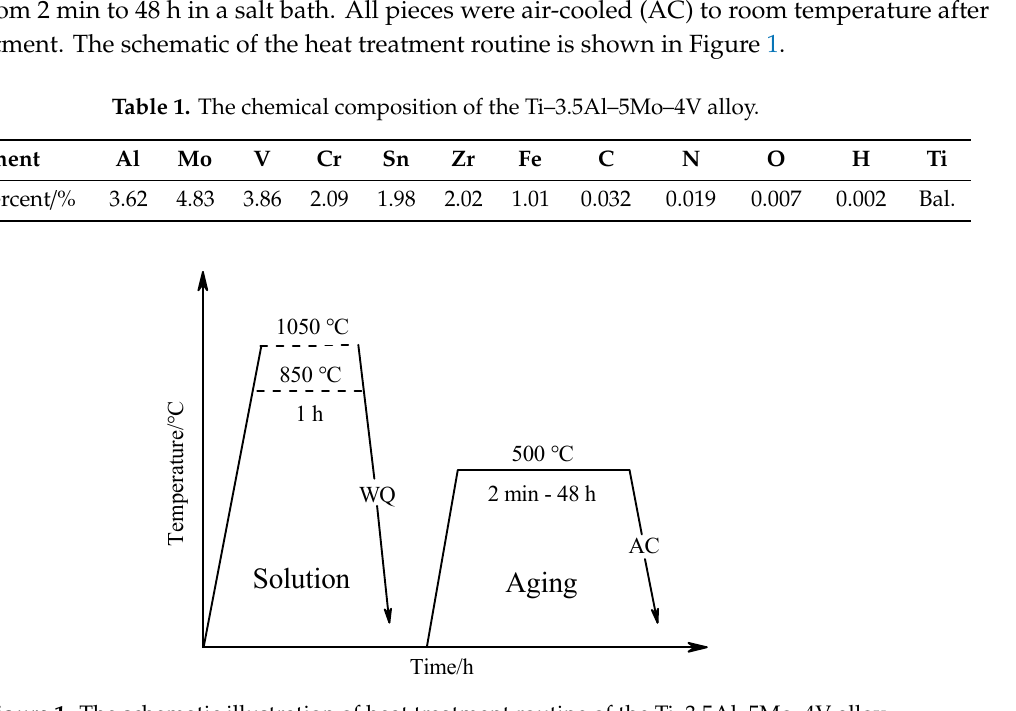
Figure 1. The schematic illustration of heat treatment routine of the Ti–3.5Al–5Mo–4V alloy.